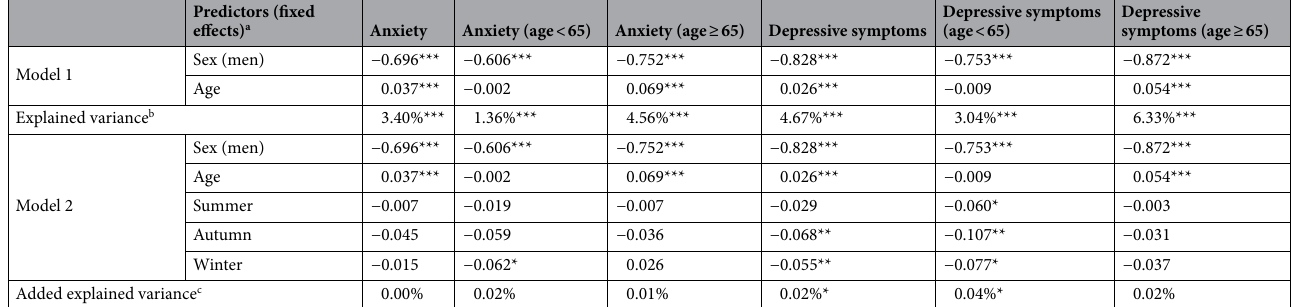
Table 3. Multilevel models predicting anxiety and depressive symptoms with seasons of birth adjusted for sex and age. Model 0 and Model 1 are the same as in the birth month prediction models. a The models are clustered across countries. b Added explained within country residual variance of the fixed effect of sex and age in comparison to Model 0. Model 0 is the unconditional model splitting the variance of the dependent variable into within cluster and between cluster parts. c Added explained within country residual variance of the fixed effects of birth months in comparison to Model 1. *p < 0.05; **p < 0.01; ***p < 0.001.